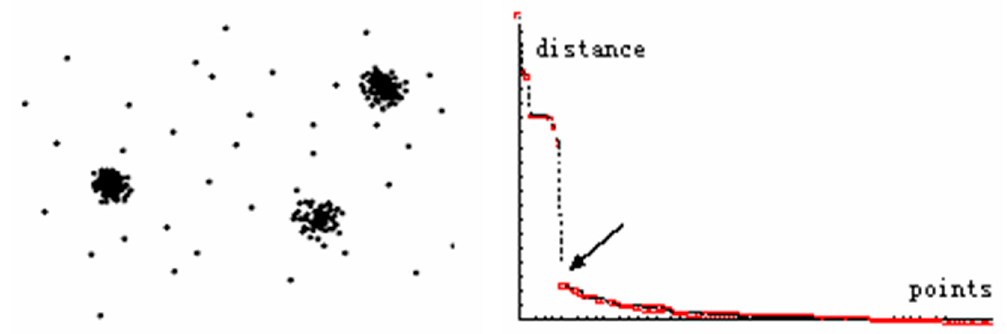
Figure 4. A point set with its sorted 4-dist graph (source: Wang, et al. [49]).